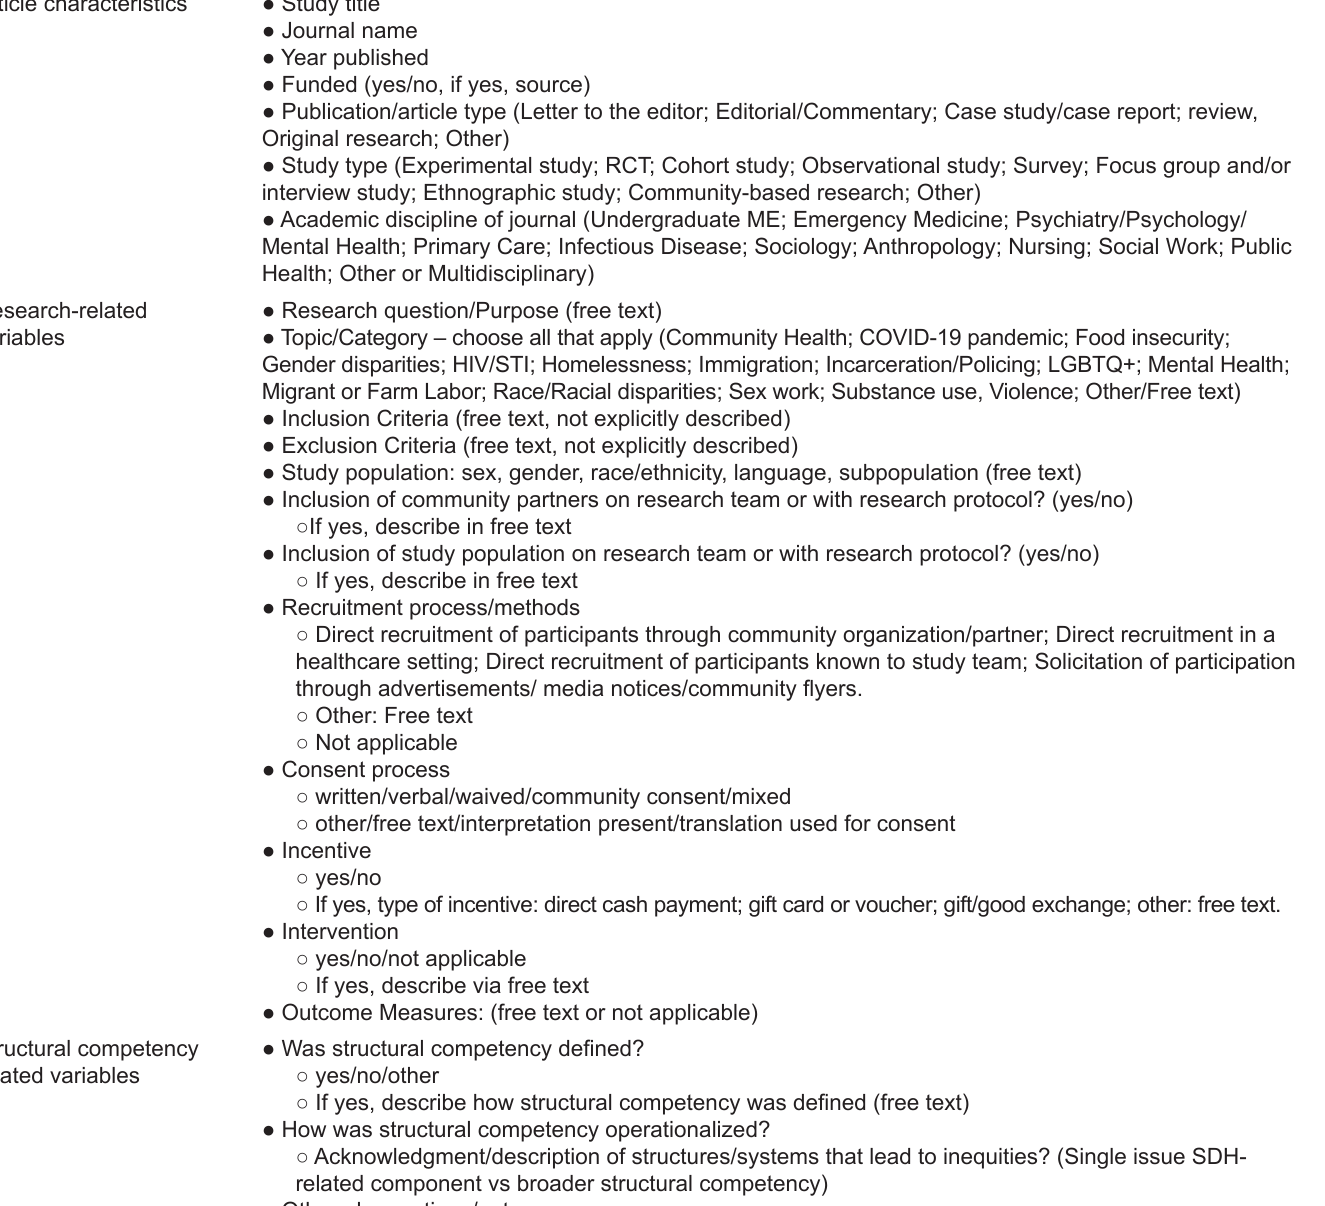
Table 1. Scoping review data-extraction